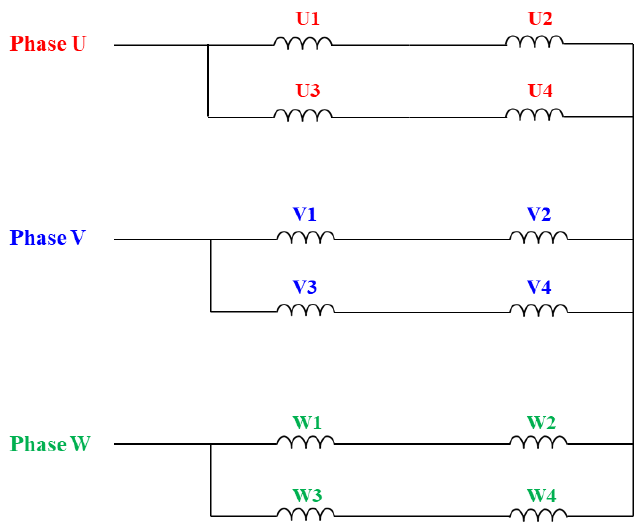
Figure 4. Winding topology of the base model.